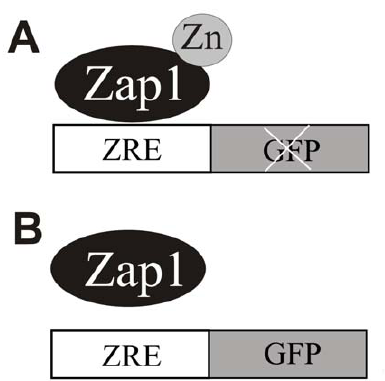
Figure 1. Model of zinc-regulated gene expression. A) Under high or normal zinc conditions Zap1 binds zinc and blocks the ZRE elements of the ZRT1 promoter and therefore inhibits GFP expression. B) Under zinc deficient conditions Zap1 releases zinc then disassociates from the ZRT1 promoter, which leads to the expression of